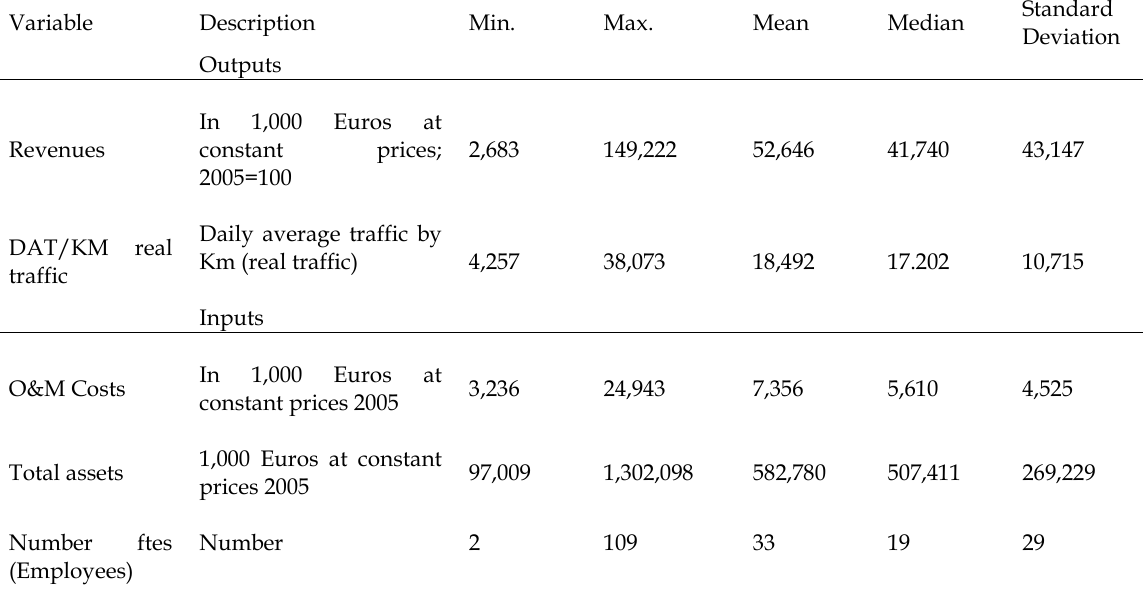
Table 4. Descriptive Statistics of input and output